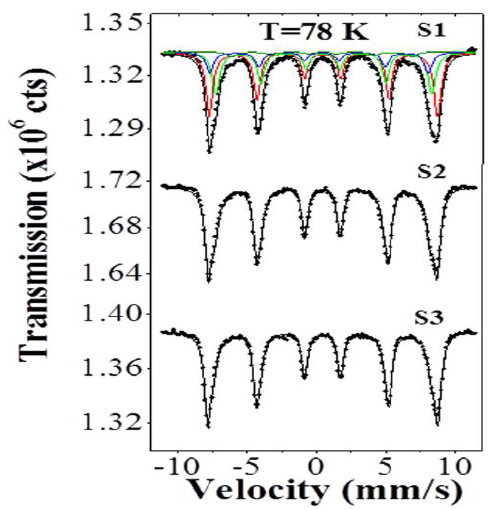
Figure 5. Mössbauer spectra, at 78 K, of the three different nanoparticle samples (the solid curves represent the fitting). The subspectra in the top of the sample labeled S1 represent the detected components. The other samples have similar subspectra. Table 1. The Mössbauer parameters at 78 K for the three different nanoparticle samples, without the